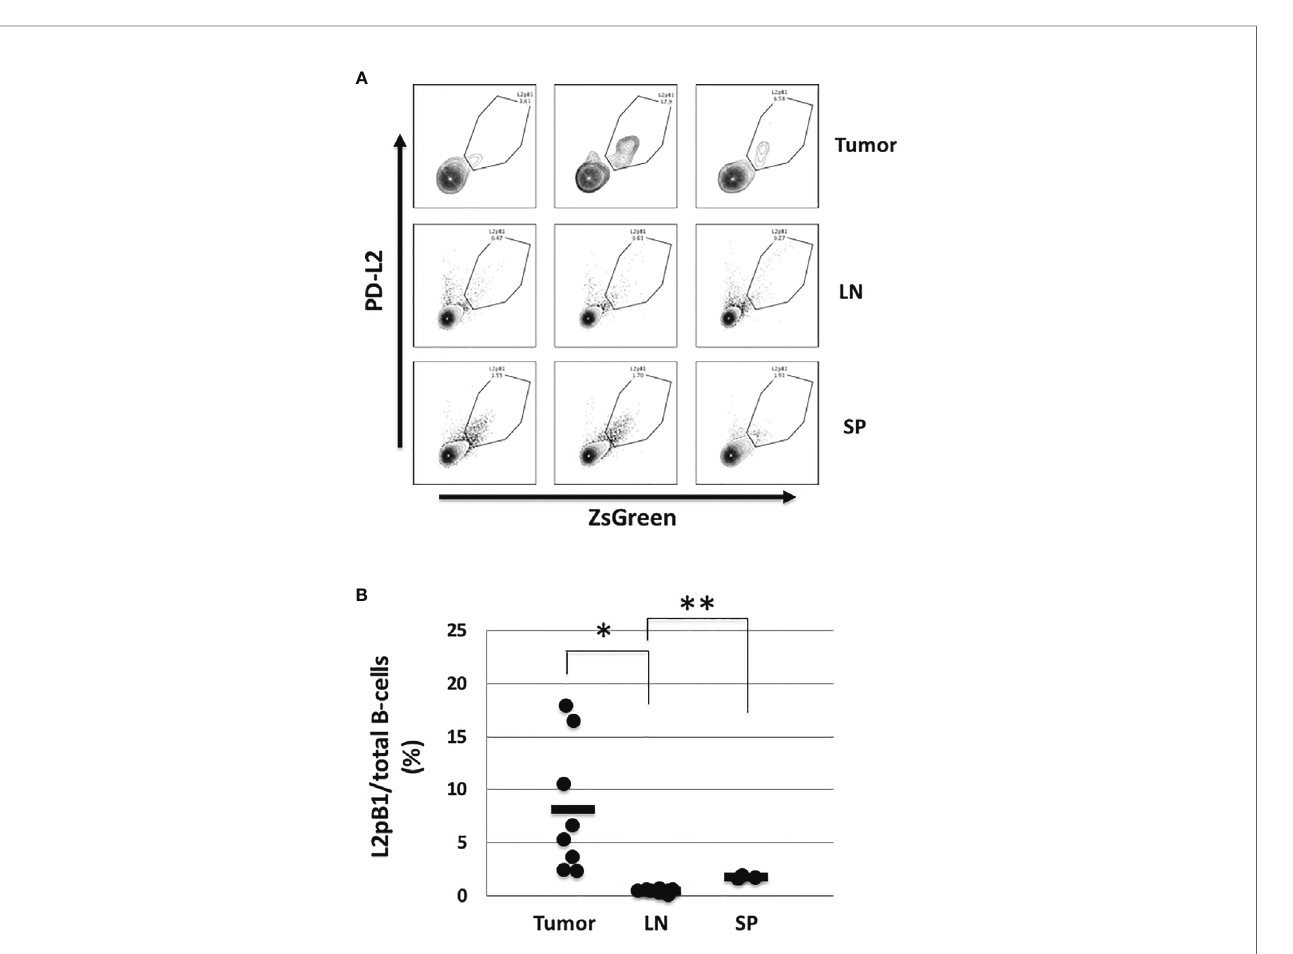
FIGURE 1 | L2pB1 cells actively accumulate in tumors. Tumors were dissected on day 18 post injection. Lymphocytes were subjected to immunophenotyping by fl ow cytometry with fl uorescently-labeled antibodies for CD45, CD3e, CD19, B220, IgM, PD-L2, and ZsGreen. (A) Representative histograms of PD-L2 + ZsGreen + L2pB1 cells in tumor, lymph nodes (LN), and spleen (SP). L2pB1 cells were identi fi ed as CD3 - CD19 + B220 + IgM + PD-L2 + ZsGreen + . (B) Percentage of L2pB1 cells from total tumor-in fi ltrating B cells as isolated from tumors (TIL), lymph nodes (LN), or spleen (SP). (*P = 0.01, **P = 0.02). Data are representative of three independent